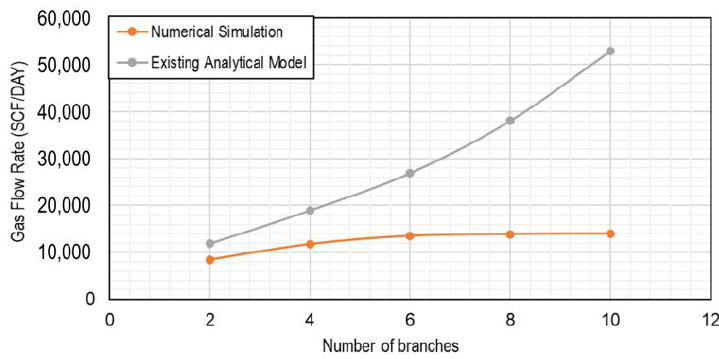
Figure 2. The effect of the number of branches on cumulative gas production.